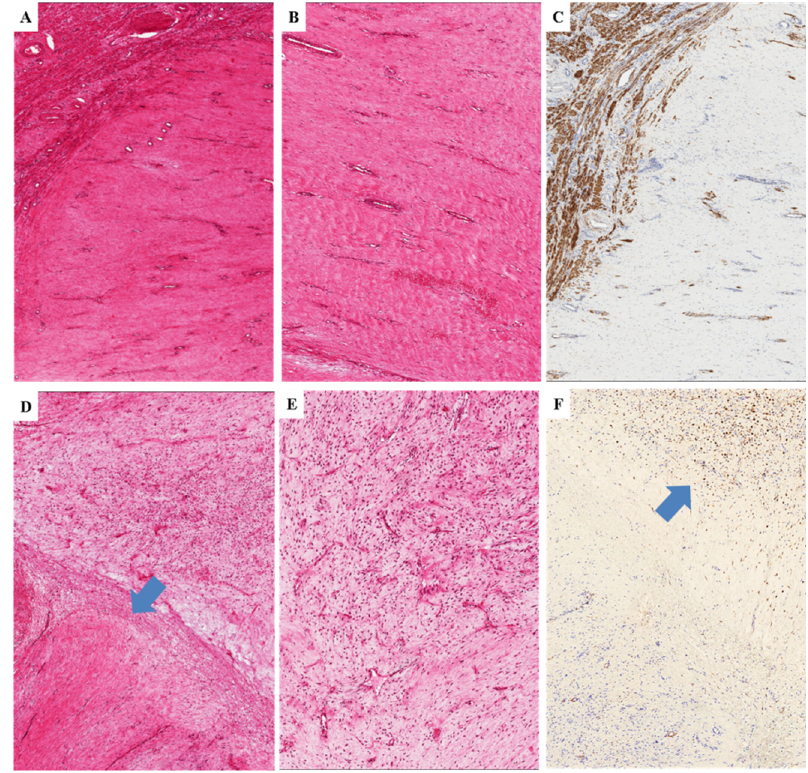
Figure 11. Recurrent DAM . Low ( A ) and higher magnifications ( B , C ) of a completely fibrosclerotic tumor infiltrating myometrium (M); ( C ) desmin expression is restricted to the smooth muscle cells of the myometrium. ( D ) Transition between fibrosclerotic tumor and area with the classic-type morphology of DAM (arrow). ( E ) The myxoid area contains numerous capillary-like vessels. ( F ) Only the neoplastic cells of the myxoid area are stained with desmin (arrow).